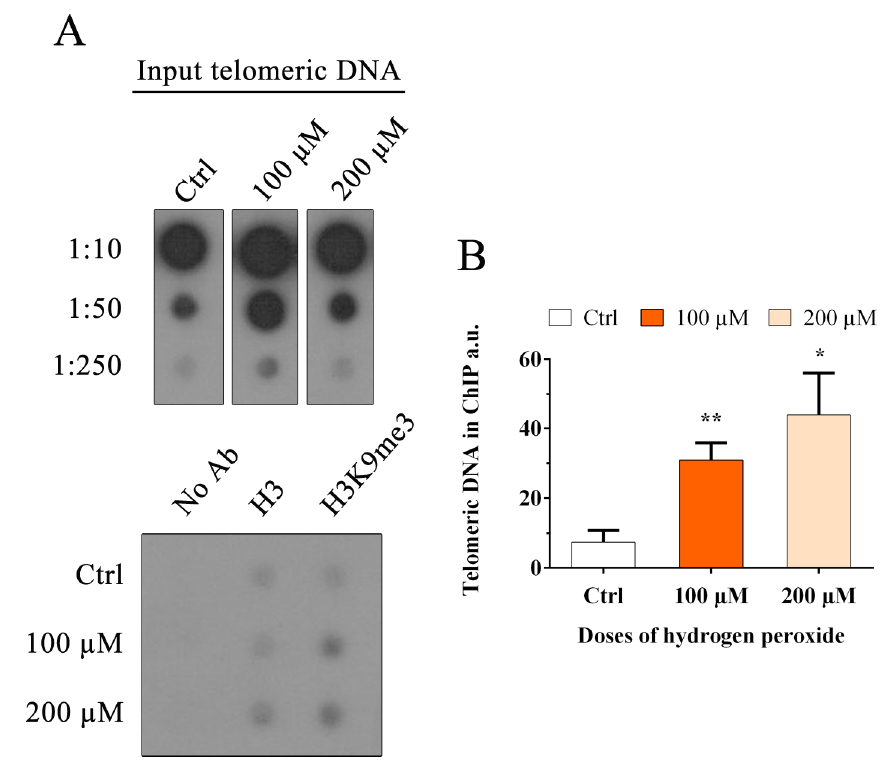
Figure 9. Chromatin immunoprecipitation and telomere dot-blot for H3K9me3. ( A ) Chromatin immunoprecipitation of MRC-5 cells after H 2 O 2 treatment (100 µM and 200 µM) with the indicated antibody (H3K9me3) and negative control (No